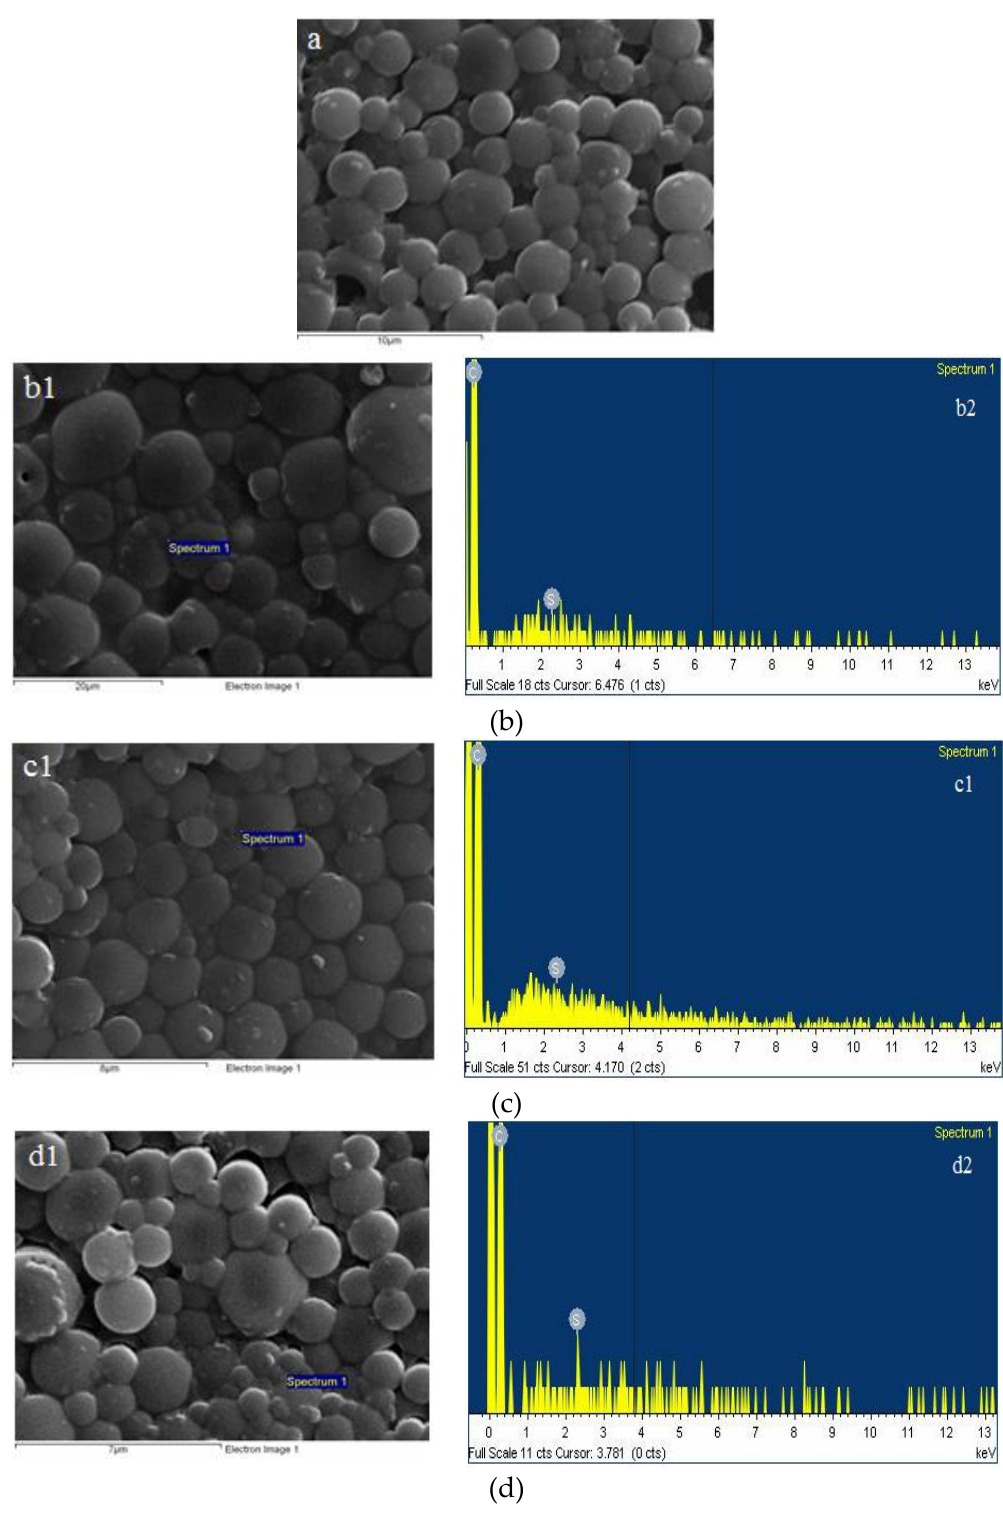
Figure 6. SEM images